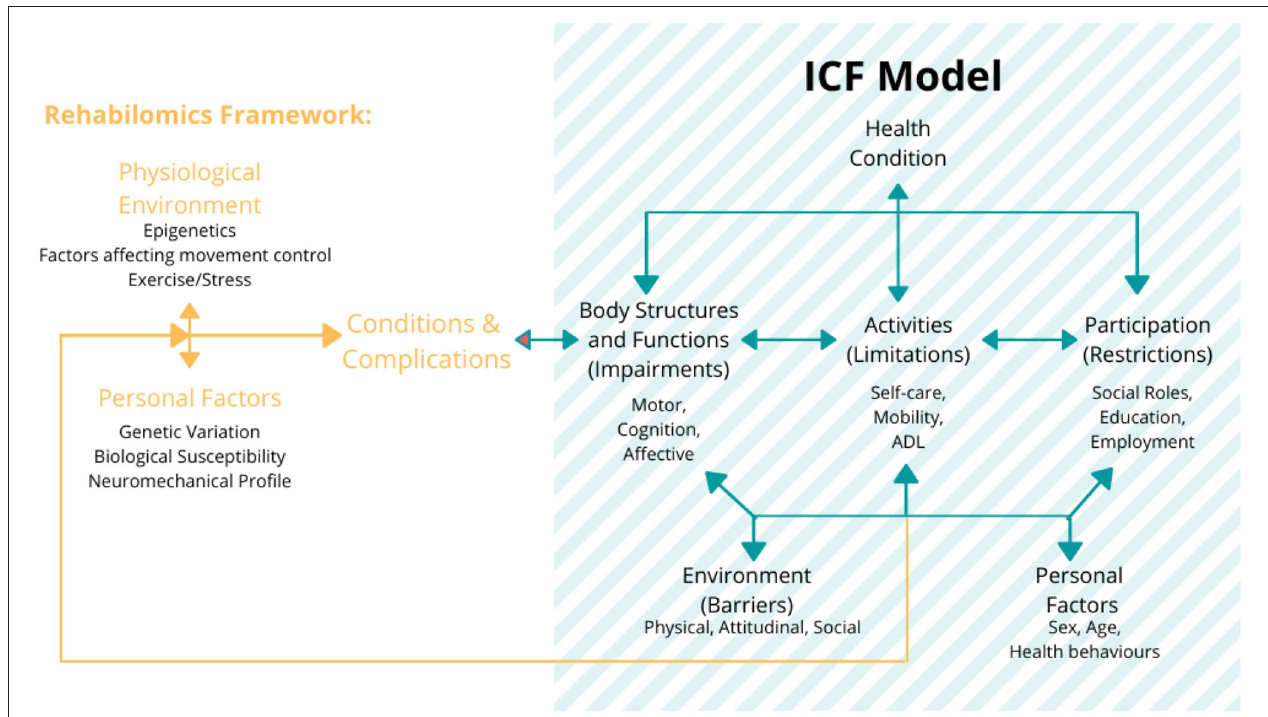
FIGURE 6 | The Rehabilomics research framework uses the WHO ICF model as a foundational representation of function for the biomarker-based assessments of the brain injury response to demonstrate how these biological constructs inform the multidimensional aspects of the motor function. The figure also describes that these functional domains affect the life satisfaction and also have feedback effects on the biological impact on the health and function. Figure is open access courtesy of the National Academies of Sciences (2021) (Trang et al., 2020). Adapted from Wang et al. (2014) with